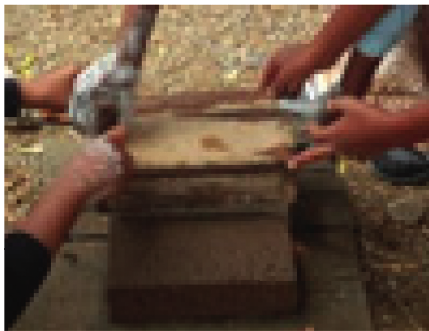
Figure 4: Moulding process.